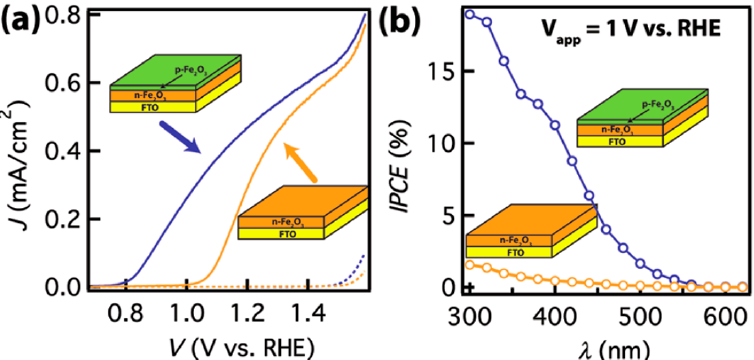
Figure 5. Photoelectrochemical characterizations of n-type Fe 2 O 3 with and without p-type coating (total thickness: 25 nm). ( a ) A significant reduction of the turn-on voltage was observed on the sample with p-Fe 2 O 3 . Data measured under 1 Sun conditions (100 mW/cm 2 , AM 1.5 G). Dark currents shown in dashed lines; ( b ) IPCE characteristics of these samples at 1 V vs. RHE. Adapted with permission from [57]. Copyright 2012 American Chemical Society.